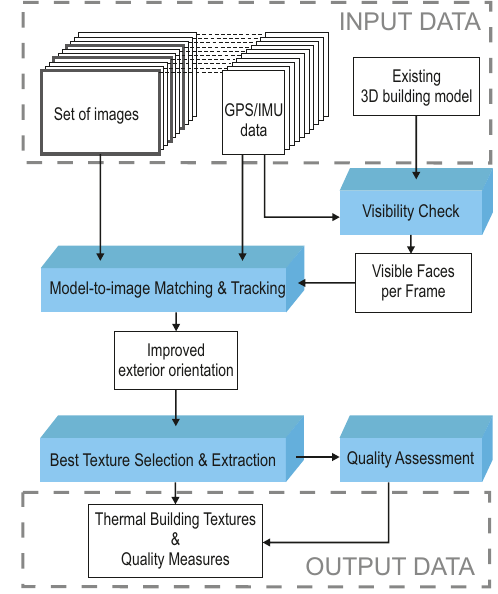
Figure 1: Extraction of thermal